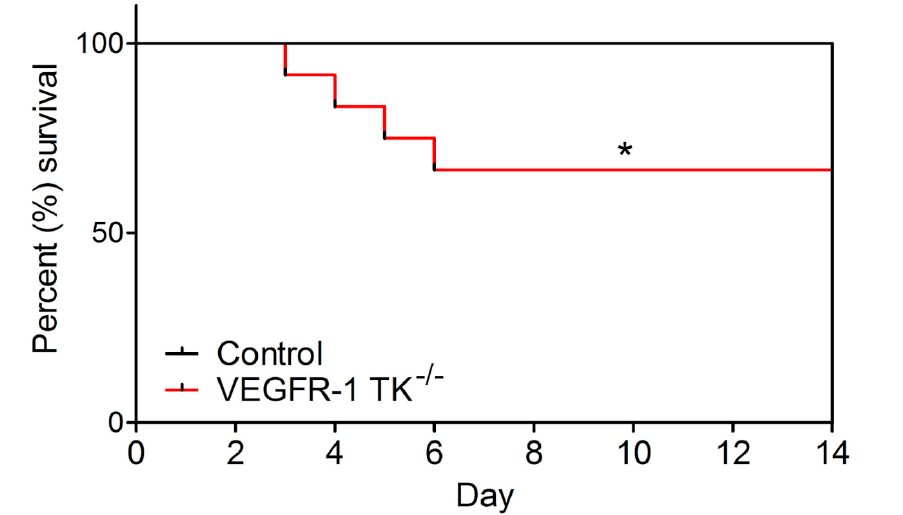
Figure 2. VEGFR-1 TK − / − mice show significantly increased mortality. Mortality of VEGFR-1 TK − / − and control mice during 14-day follow-up after angII infusion (n = 10–13/group). Values are mean ± SEM. Statistical analysis was performed using Kaplan–Mayer with log-rank test for survival curve. *** p < 0.001; ** p < 0.01; * p <